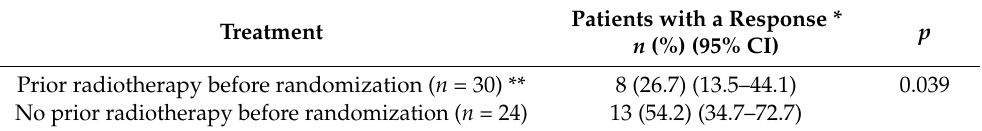
Table 3. CNS objective response rate in the cFAS by prior brain